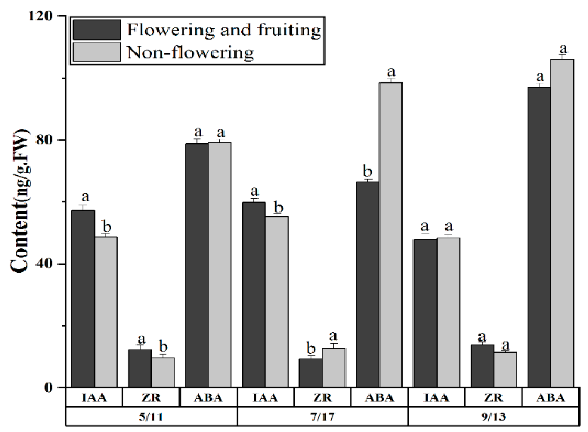
Figure 4. Differences in the endogenous hormones between flowering and fruiting plants and nonflowering plants at different growth stages. The different letters reflect significant differences among different indexes in the same stage.